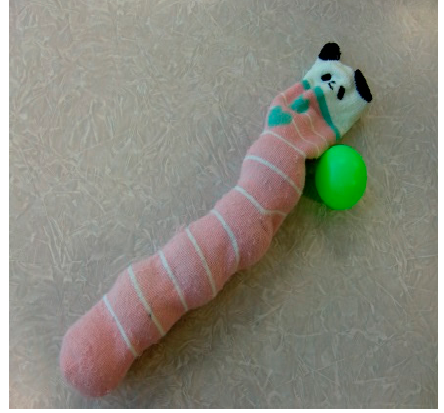
Figure 2. Filling a sock with balls (created using unneeded socks). Figure 2: Children enjoy movements to fill socks with balls and take them out, as well as various sensations when touching these materials.